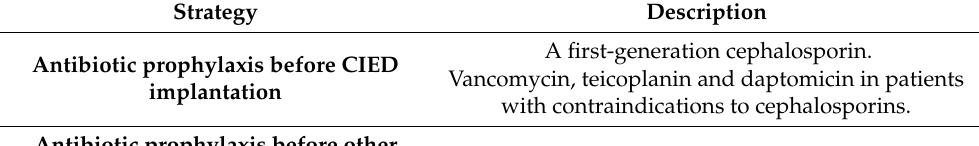
Table 3. Preventive strategies for cardiac device-related infective endocarditis.